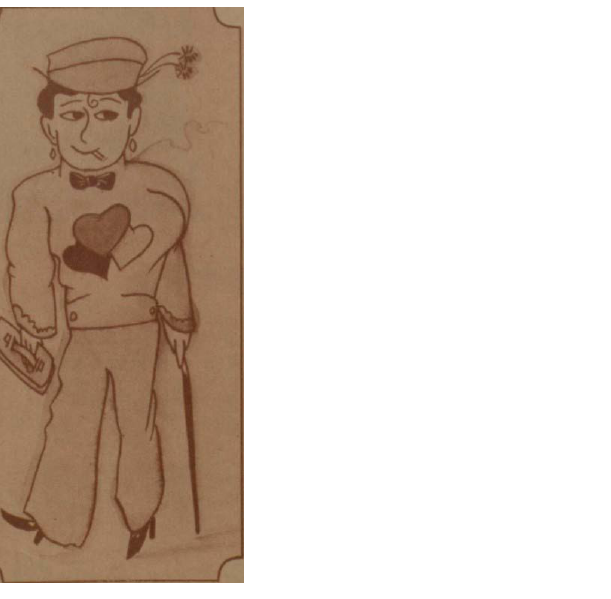
Figure 3. ‘Ch sei jinbutsu’ [Androgynous Person], Asahi Gurafu [Asahi Graphic], 1928, vol. 10, no. 9: ū 27. The magazine caption labels this person as a ‘ mogabo ,’ a composite figure of the moga and mobo.